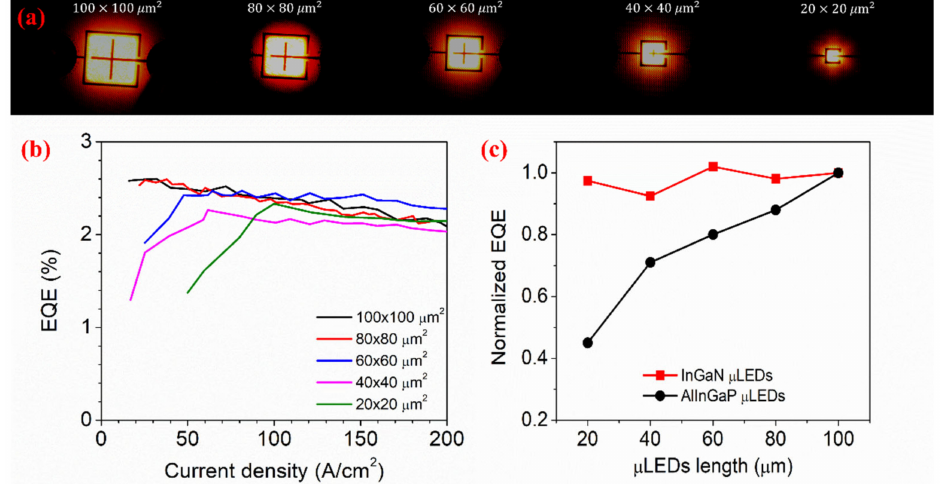
Figure 1. ( a ). EL images of InGaN red µ LEDs by microscope; ( b ) EQE curves of InGaN red µ LEDs; ( c ) comparison of normalized peak EQE for different sizes InGaN and AlInGaP red µ LEDs. These figures are reproduced from [6], with the permission of AIP